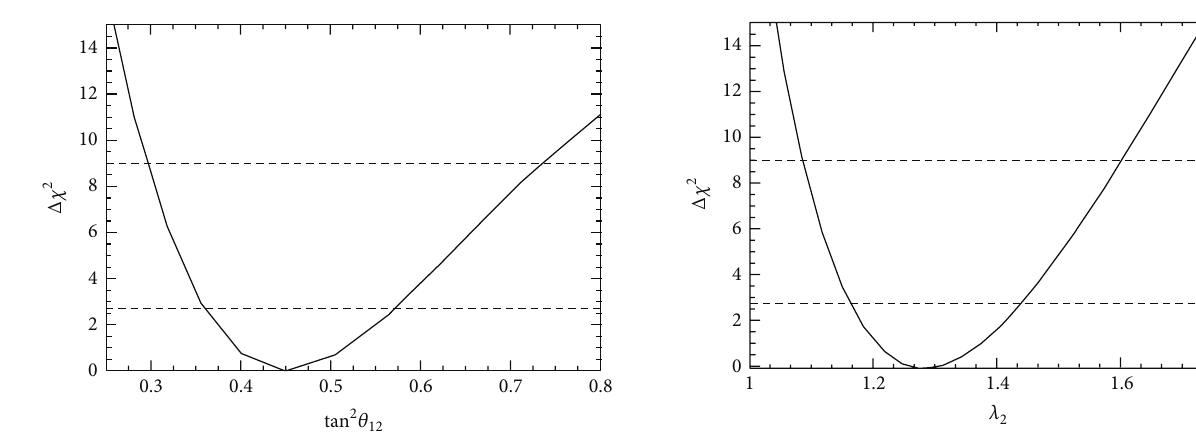
Figure 7: Δ𝜒 2 as a function of tan 𝜃 , when the other parameters are fixed in the best fit point, given by (16). Dotted lines indicate, from bottom to top, 90% and 99.73% confidence levels.